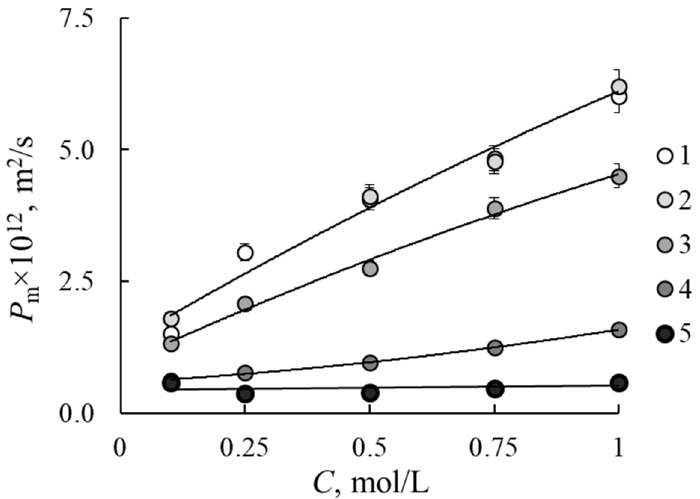
Figure 1. Concentration dependencies of membranes diffusion permeability in NaCl solutions: 1— M0, 2—M10, 3—M20, 4—M30, 5—M40. 1—M0, 2—M10, 3—M20, 4—M30,